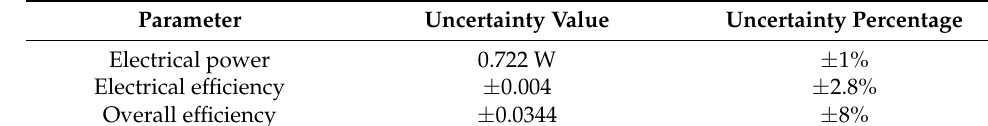
Table 4. The uncertainty in the performance parameters.